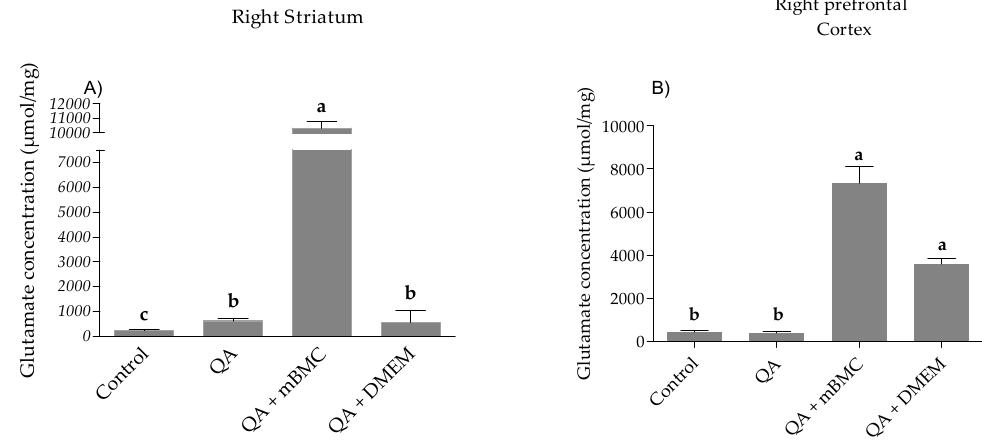
Figure 2. Study of glutamate (GLU) concentration in lesioned rats with transplanted mBMC. ( A ) Comparison of GLU concentration in the right striatum among the experimental groups: H (3, 20) = 16.28, p < 0.001. ( B ) GLU concentration in right prefrontal cortex among the experimental groups: H (3, 19) = 15.53, p < 0.001. Data are expressed as mean ± SEM. The letters in the top the bar correspond to statistical differences among the experimental groups. The data analysis was carried out through one-way non parametric ANOVA, using the Kruskall–Wallis test (common letters: non-significant differences; different letters; significant differences).QA lesion (Group II); lesioned group with QA + transplant (QA+mBMC, Group III); and lesioned group with QA+DMEM transplant (QA+DMEM, Group IV).